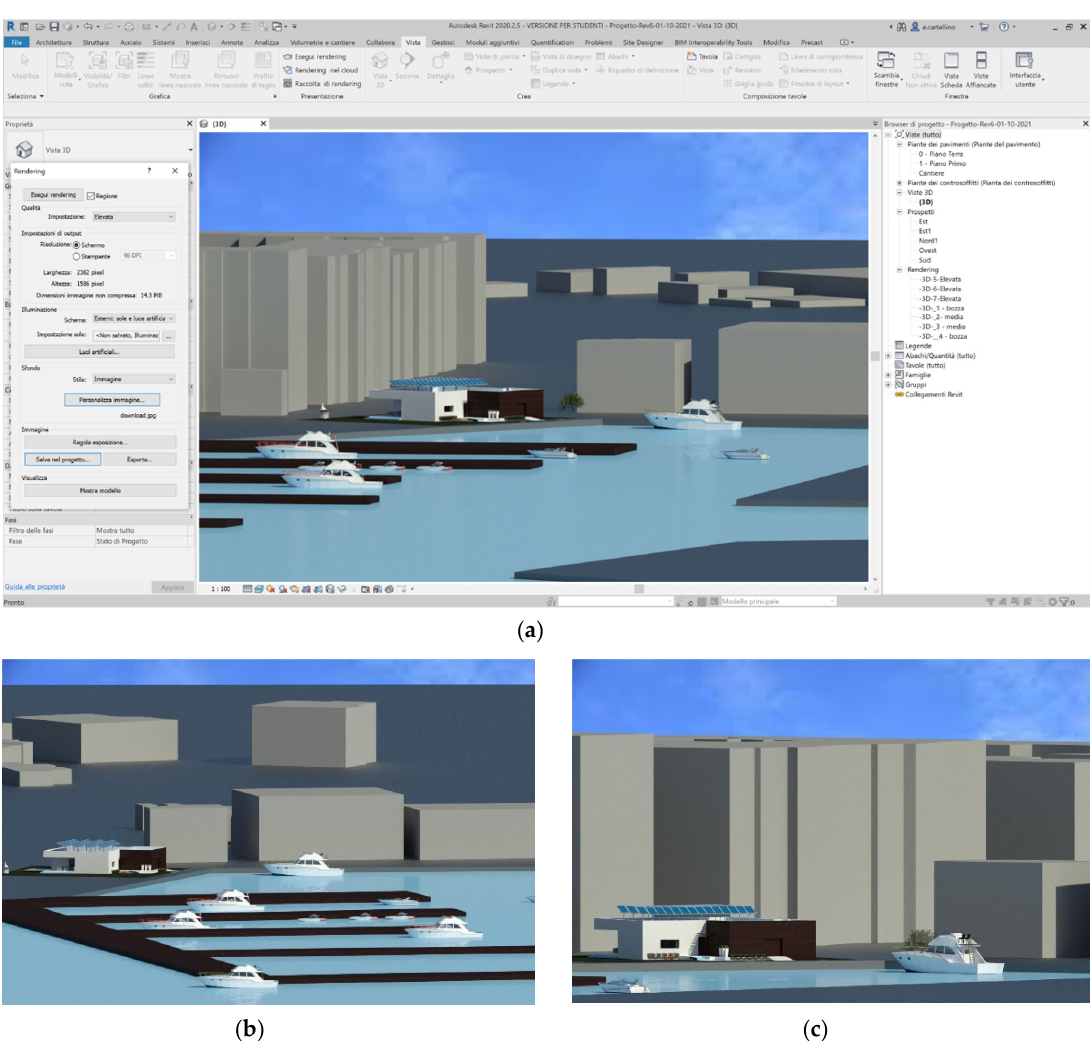
Figure 7. Screen-shot in Revit software of coastal area regeneration project within the 3D city model ( a ); examples of renderings of 3D views ( b , c ).